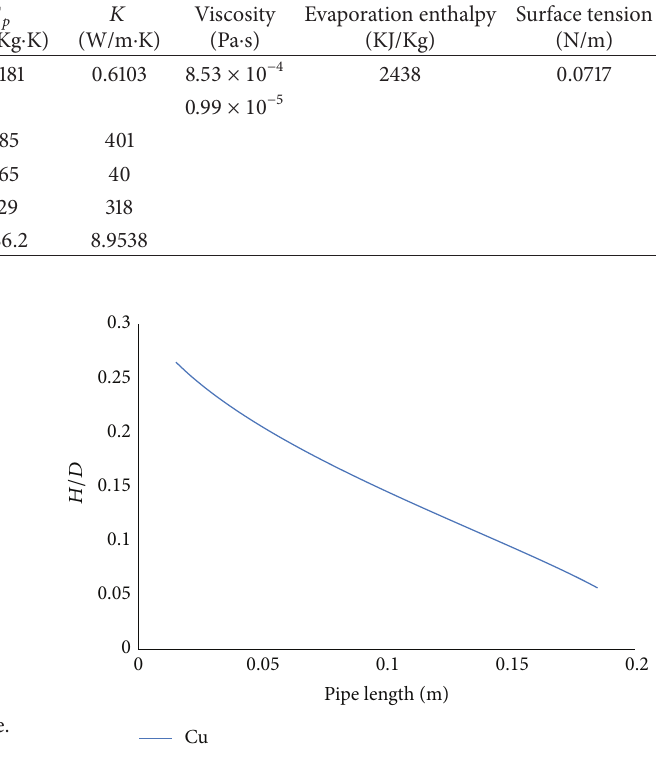
Figure 8: Variation of liquid film thickness against the pipe length for nanofluid with copper